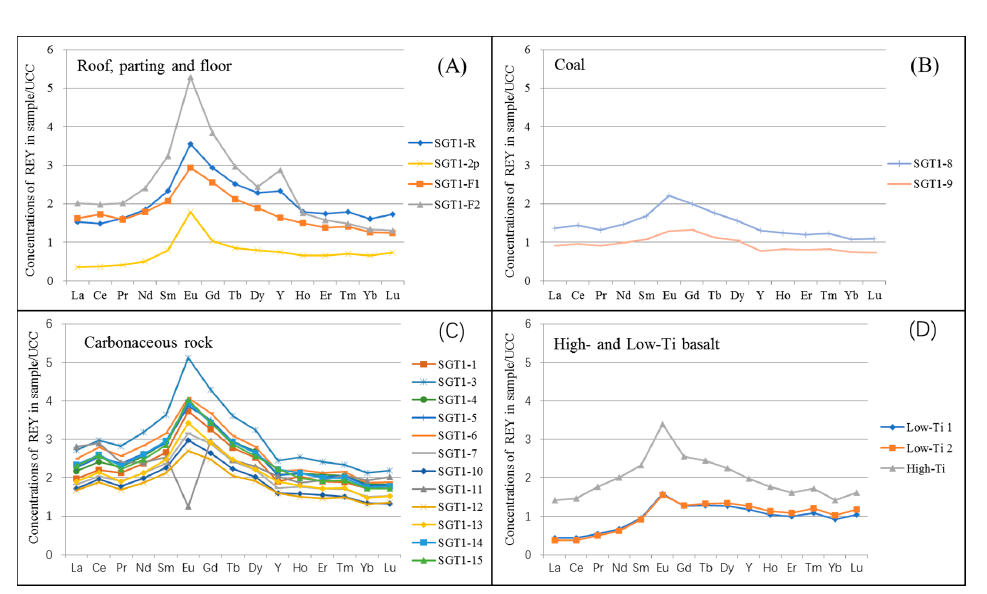
Figure 4. Distribution patterns of rare earth elements and yttrium (REY) of samples in Shugentian coalfield ( A – C ). REY are normalized by the Upper Continental Crust (UCC) [67]. Data for high- and low-Ti alkali basalts ( D ) are from Xiao et al. [71].